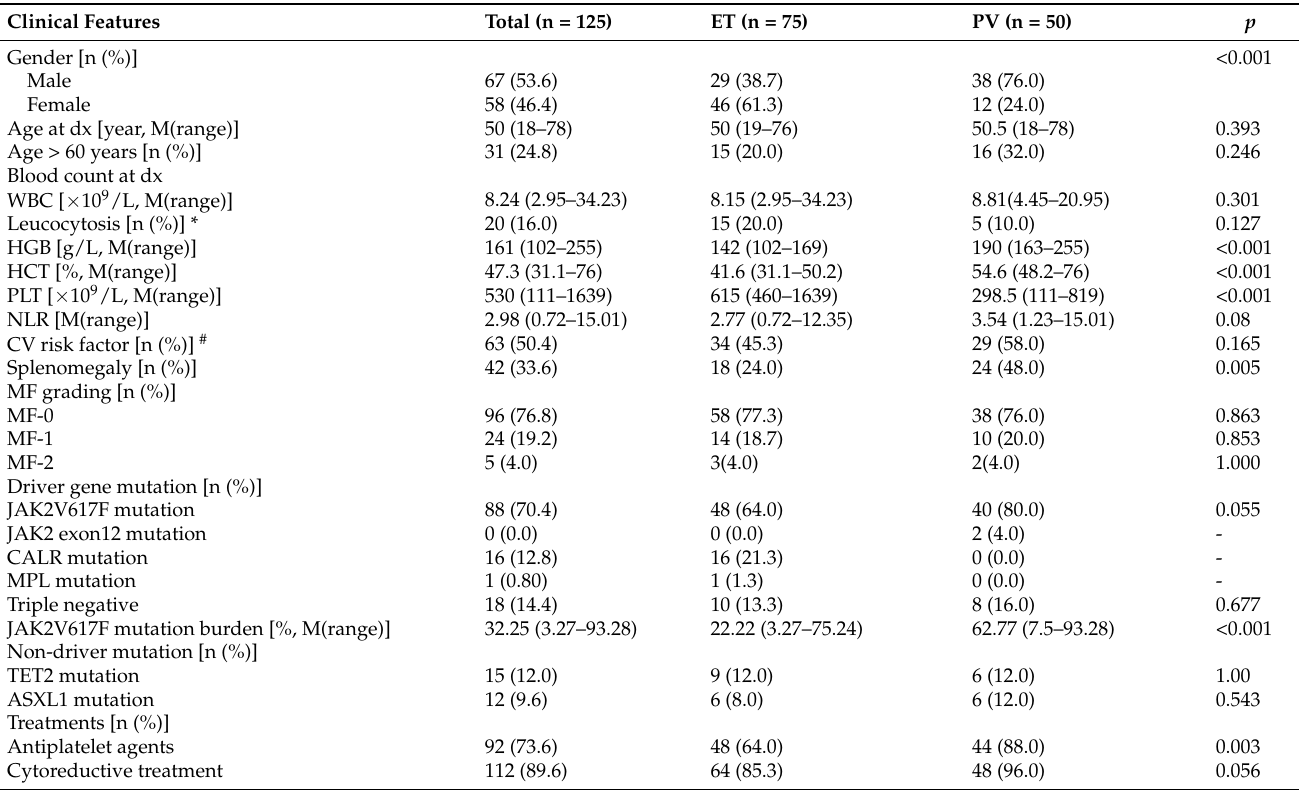
Table 1. Clinical characteristics of 125 patients with MPN.